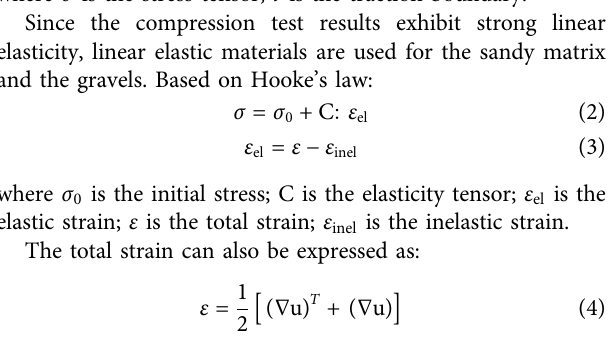
Frontiers in Earth Science |